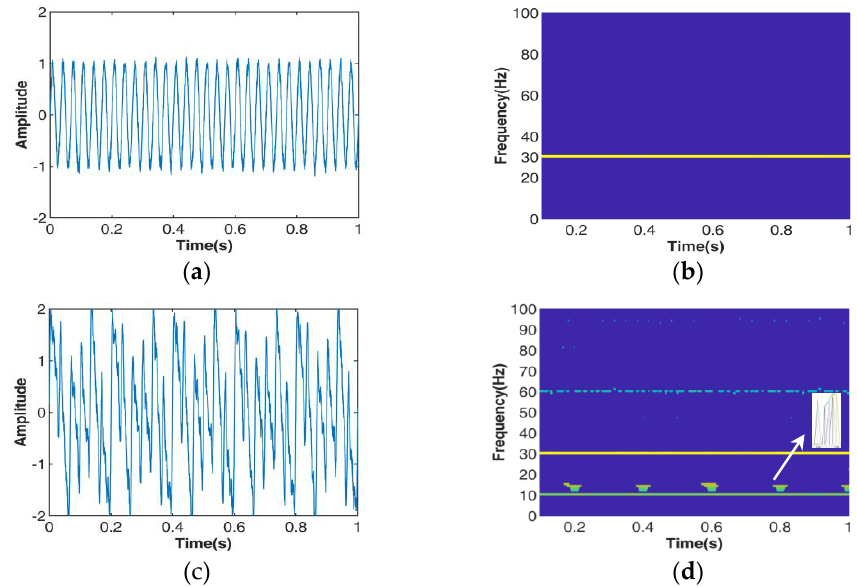
Figure 10. Comparison of rotor in both normal and bearing wear vibration states. ( a ) Time domain representation of rotor in normal state; ( b ) SEST time-frequency representation of rotor in normal state; ( c ) time domain representation of rotor bearing wear vibration; ( d ) SEST time-frequency representation of rotor bearing wear vibration.